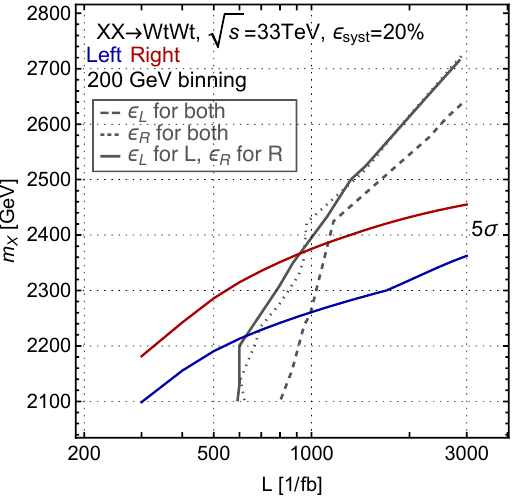
Figure 10 . Projected discovery (blue and red) and discrimination (gray) reach of the 2SSL search for a X VLQ decaying with 100% branching ratio into the Wt (cid:12)nal state at the p T distribution of the sub-leading lepton with a binning of 200 GeV and assume an uncertainty on the background determination of